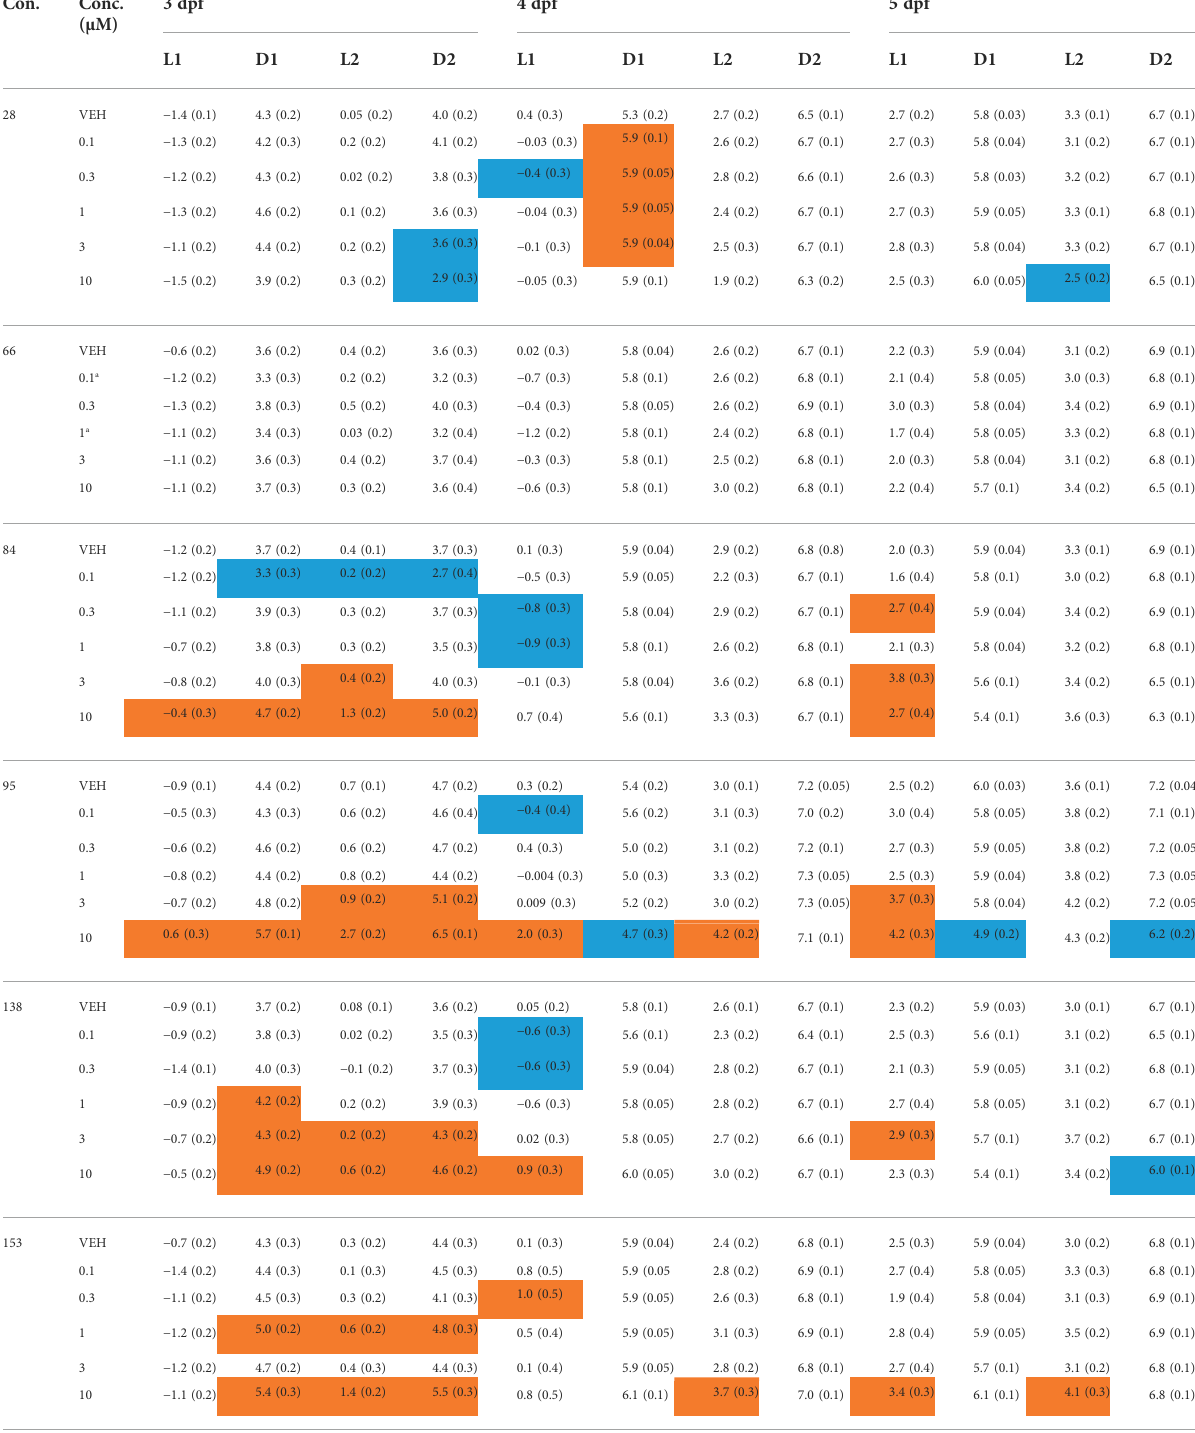
TABLE 2 Behavioral results at 3, 4, and 5 dpf for PCB-exposed and vehicle control larvae.